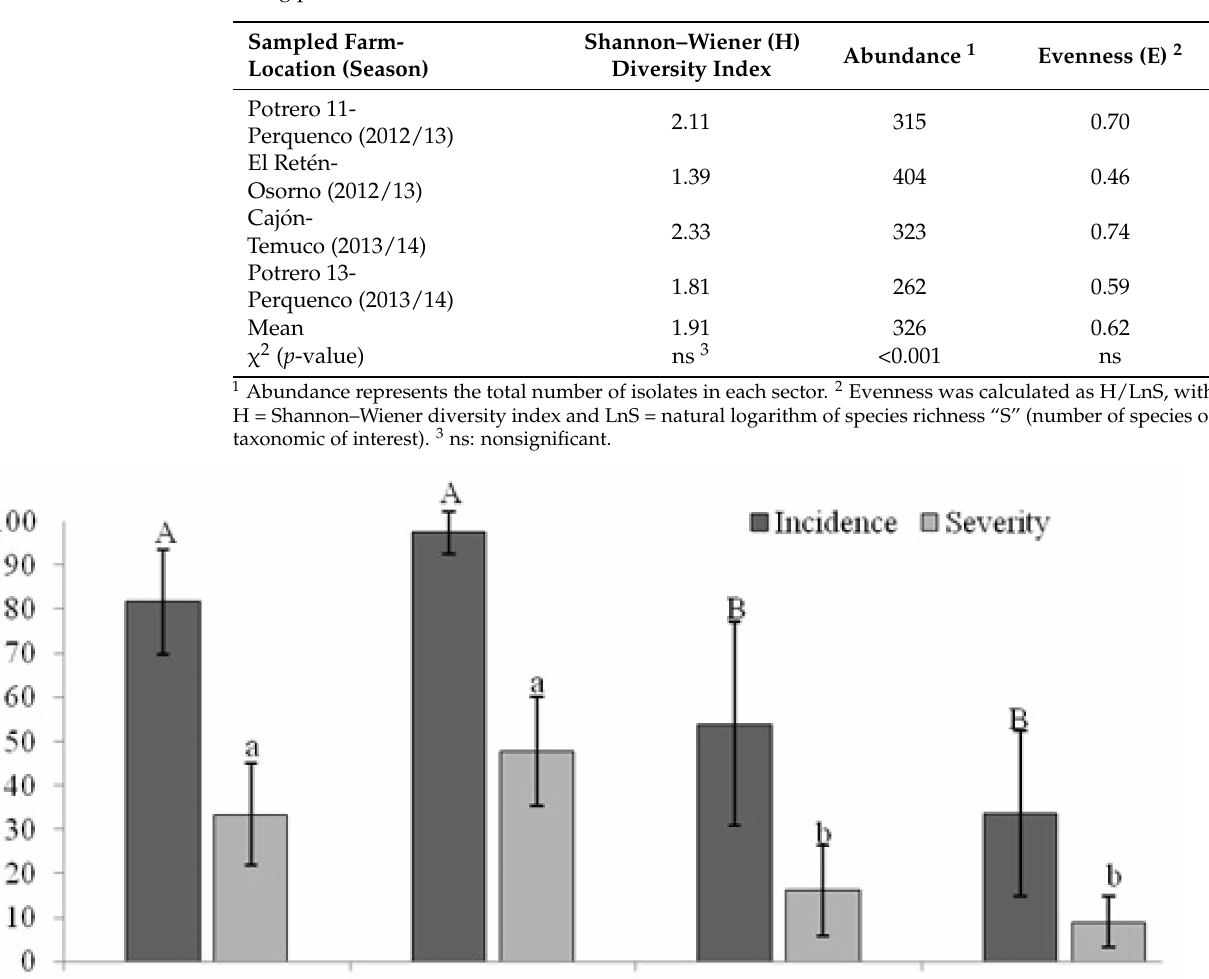
Table 3. Indices of abundance and evenness of fungus associated with the crown or the first internode of wheat culms observed in four intensively sampled fields of southern Chile during the grain- filling period.